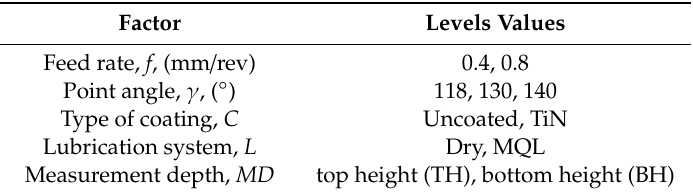
Table 2. Factors and their